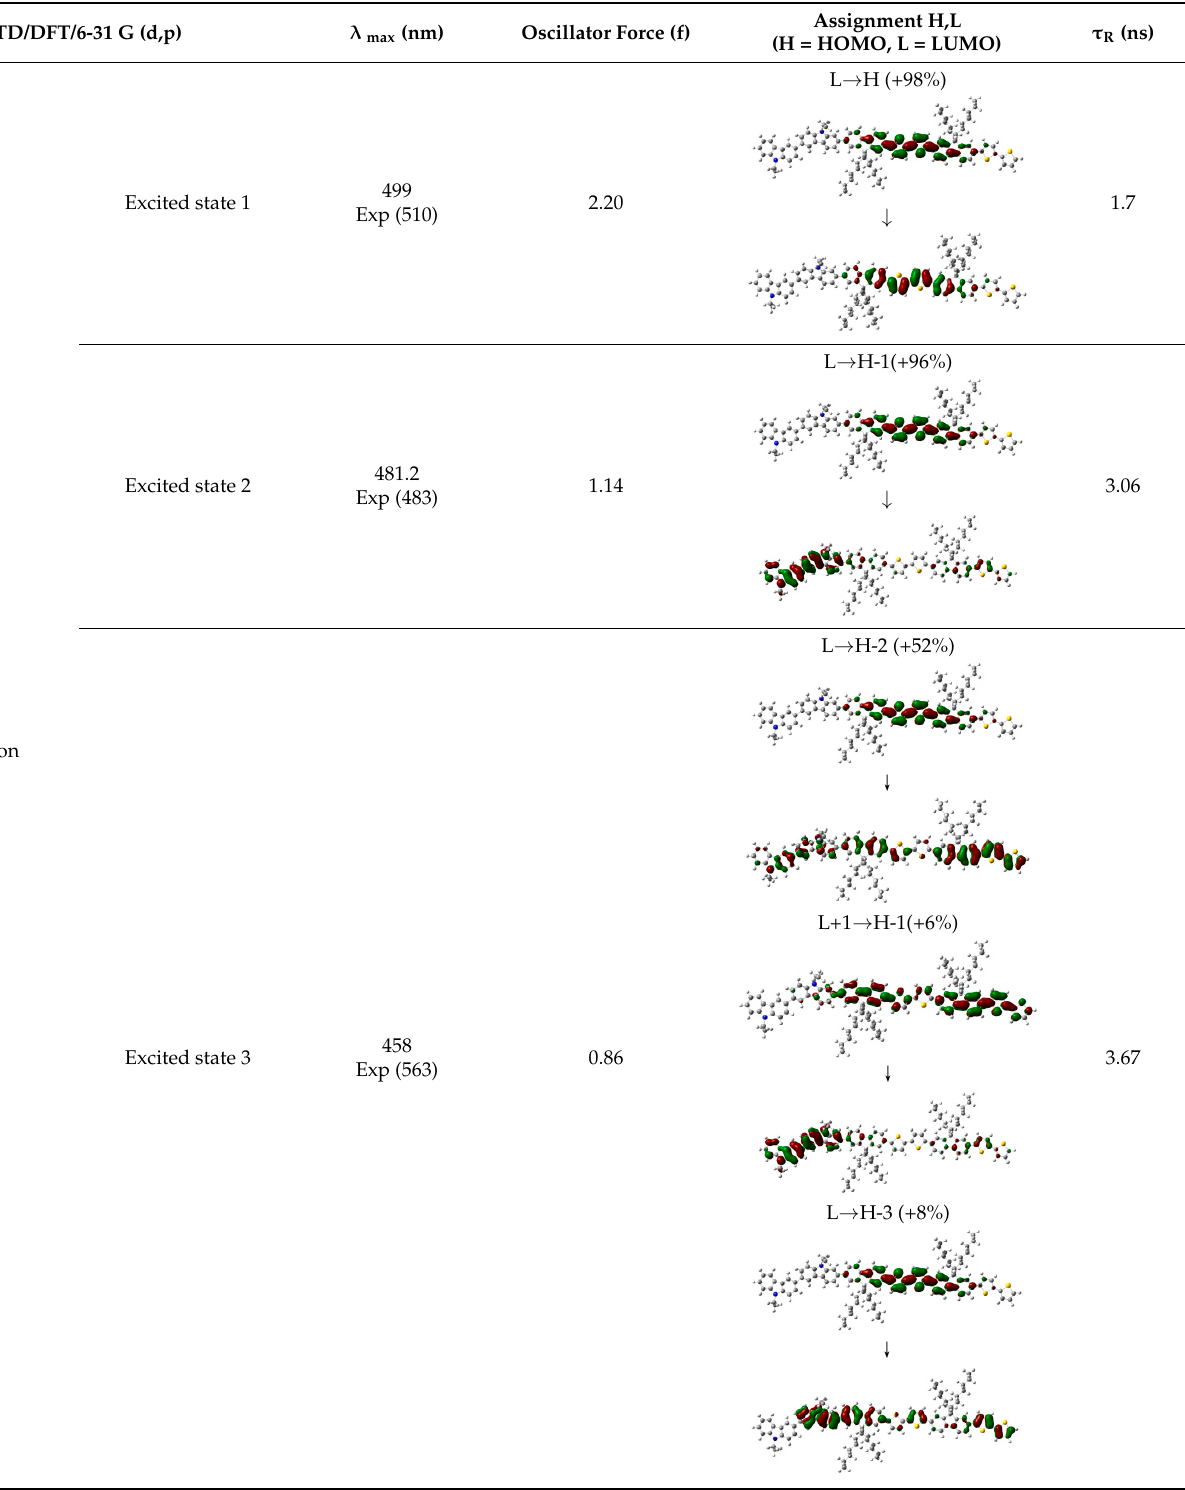
where c is the speed of light, E fluo is the E max , and f is the oscillator force. Table 2. Assignment of the PVK-F8T2 electronic transitions.